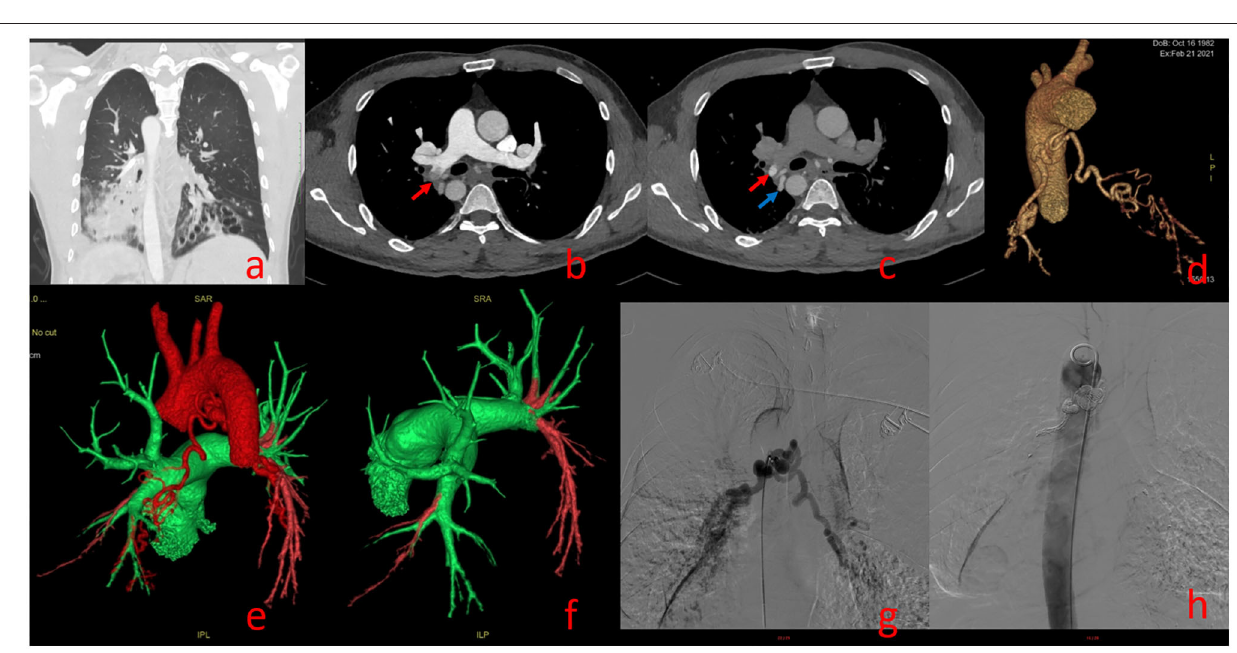
FIGURE 4 | Systemic-Pulmonary Shunt artifacts ( Supplementary Video 6 ). A 39-year-old man with Kartagener syndrome underwent dual phase-computed tomography pulmonary angiography. Bronchiectasis of lower lobes of both lungs in (a) . (b) (pulmonary artery phase): Filling defect can be seen in the right lower pulmonary artery [red arrow in (b) ]; (c) (aortic phase): the filling defect shown in (b) shows high density in (c) [red arrow in (c) ], and its density is similar to that of the adjacent bronchial artery [blue arrow in (c) ]; Three dimensional reconstruction showing thickening of bronchial artery trunk in (d) ; (e,f) show bronchial-pulmonary artery shunt, Green represents the normal blood flow of pulmonary artery and red represents the normal blood flow of aorta; bronchial-pulmonary artery shunt confirmed by angiography and treated by bronchial artery embolization in (g,h)